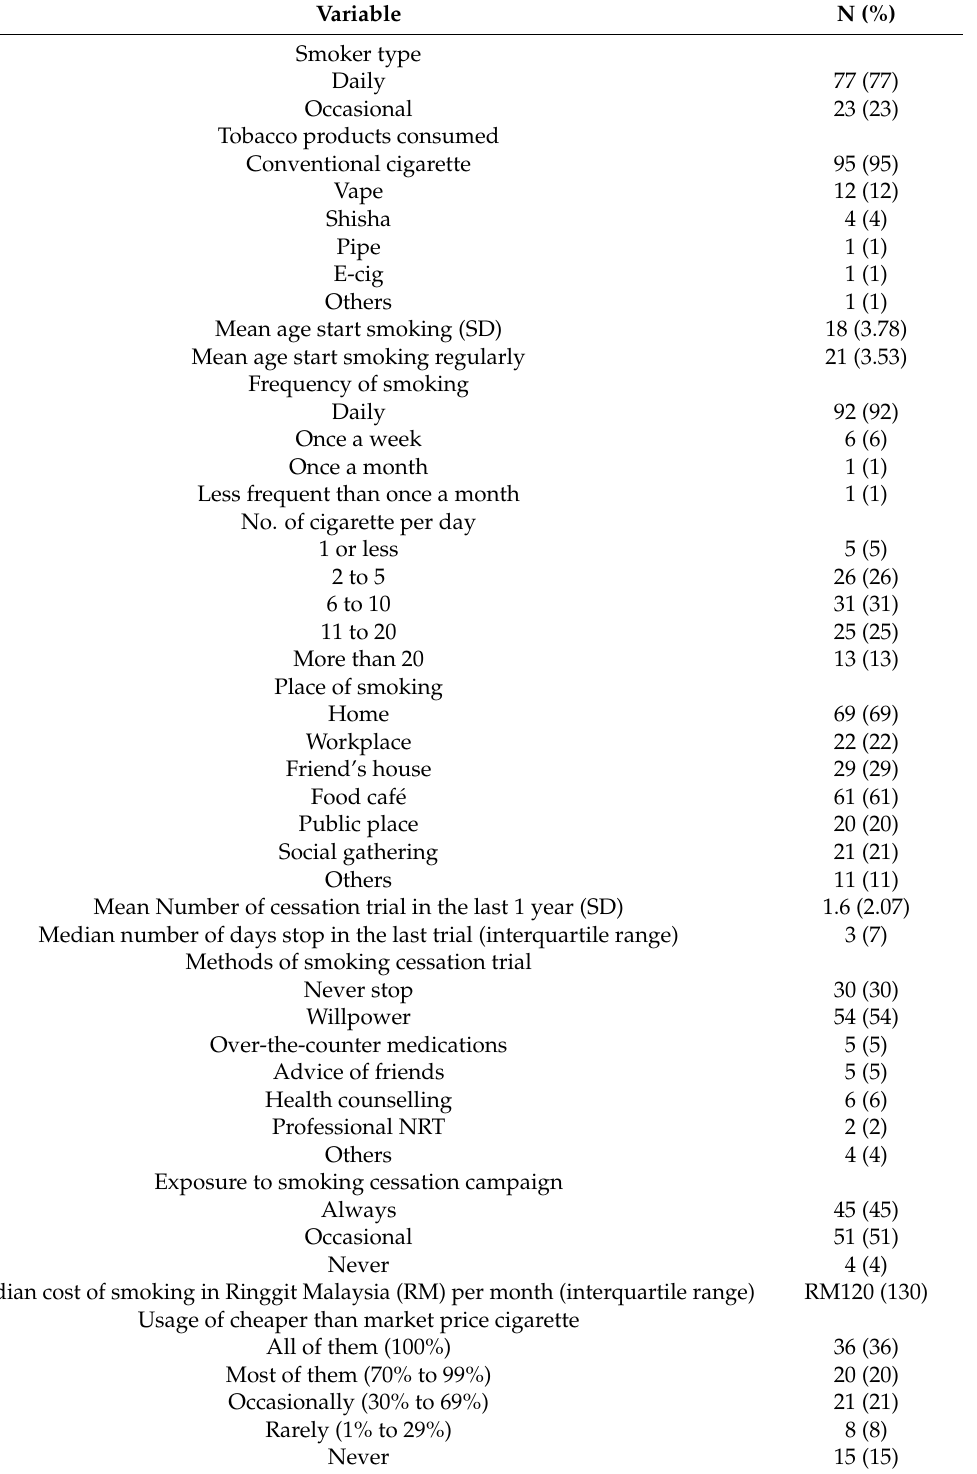
Table 4. Data about smoking, cigarette cessation, and their